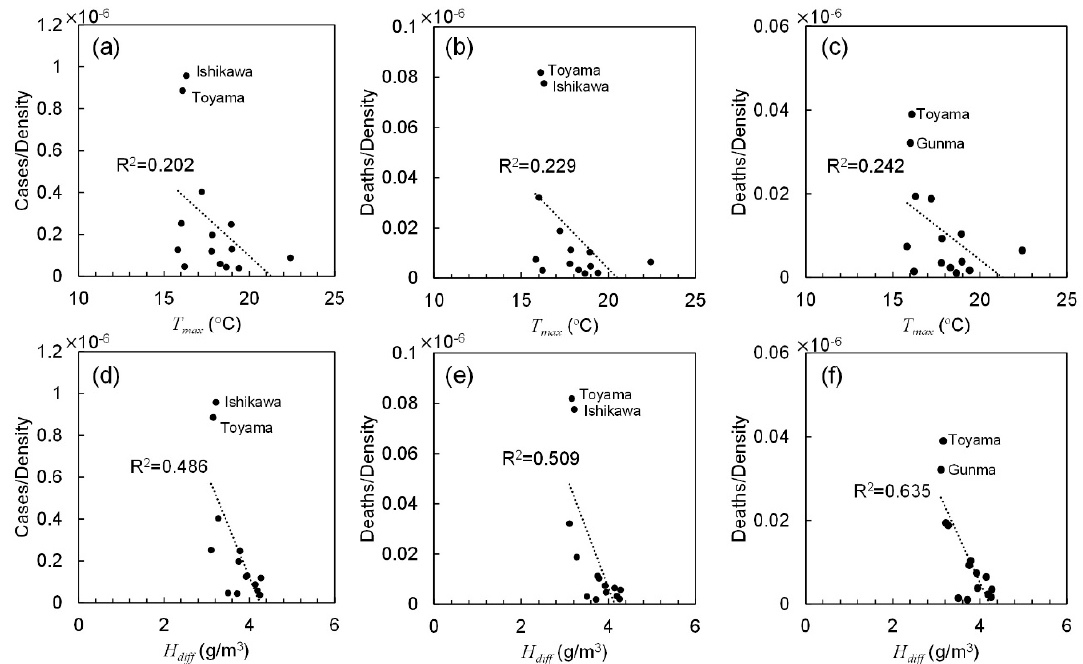
Figure 4. Correlation between the number of confirmed positive cases and fatality normalized by the population density and ( a – c ) the daily maximum temperature and ( d – f ) diurnal absolute humidity averaged over total duration. The number of ( a , d ) positive cases, confirmed deaths ( b , e ) including and ( c , f ) excluding those caused by nosocomial infection.